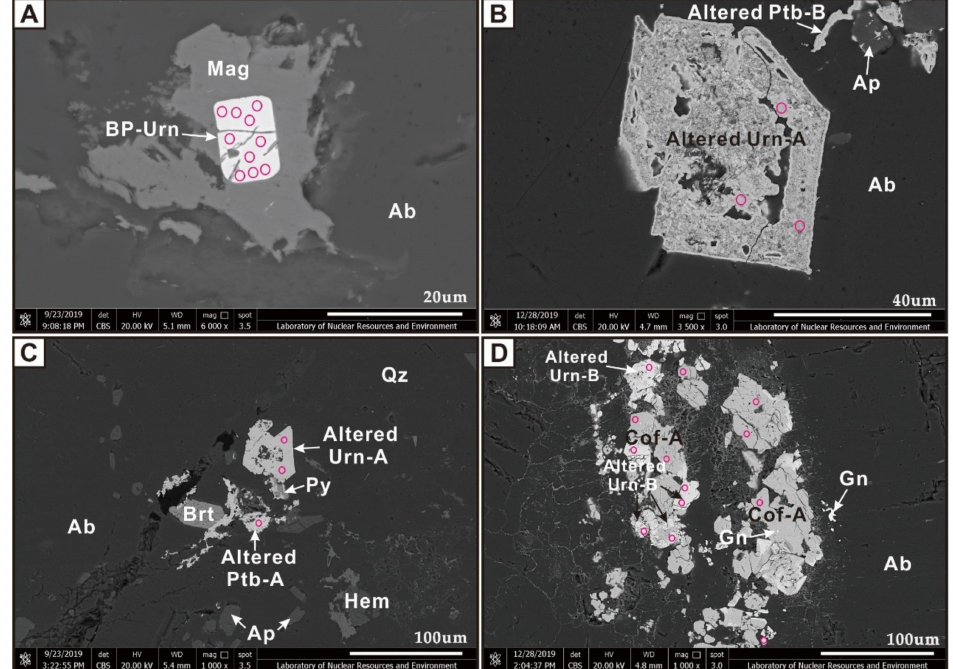
Figure 4. Backscattered electron (BSE) images of the best preserved uraninite (BP uraninite) crystal and altered uraninite A and B in the Jiling uranium deposit. ( A ) The BP uraninite crystal coexisting with magnetite and associated with albite. ( B ) Altered uraninite A associated with albite, altered pitchblende B and apatite are nearby ( C ) Altered uraninite A associated with albite and pyrite, altered pitchblende A, barite, hematite, and apatite are nearby. ( D ) Altered uraninite B preserved in the core or at the margin of co ffi nite grains (co ffi nite A), and coexisting with galena. Ab—albite; Ap—apatite; Brt—barite; Cof—co ffi nite; Gn—galena; Hem—hematite; Mag—magnetite; Ptb—pitchblende; and Urn—uraninite. Red circles indicate the location of electron microprobe analyzer (EMPA)